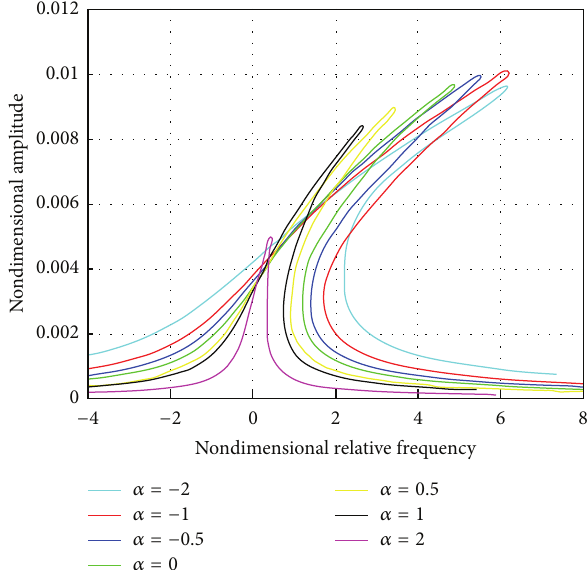
Figure 7: Frequency response of a nonlinear uniform beam 𝛼 = 0 . grid points is adopted for the rest of the simulations. For 𝑛 = 19 , the vibration amplitude is small when the forcing frequency is away from the first resonant frequency ( 𝜔 1 = 24.658